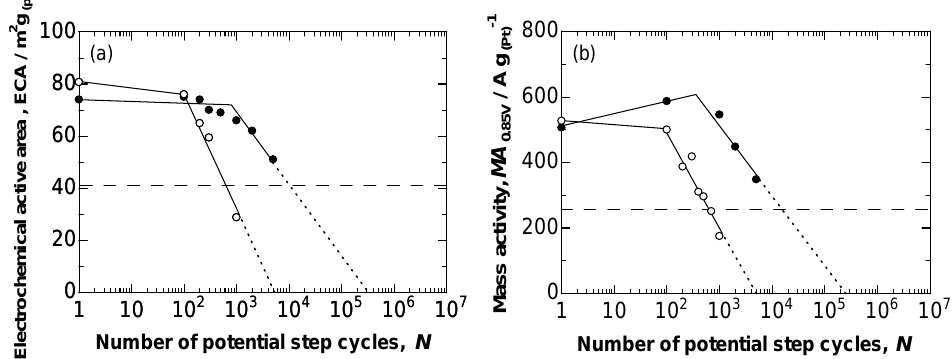
Figure 8. ( a ) Plots of ECA at Nafion-coated ( ● ) Pt/TiC-600 °C and ( ○ ) c-Pt/CB electrodes as a function of log N . ( b ) Plots of MA 0.85V at Nafion-coated ( ● ) Pt/TiC-600 °C and ( ○ ) c-Pt/CB electrodes at 0.85 V as a function of log N . Each dashed line indicates 1/2 of the initial value of ( a ) ECA and ( b ) MA 0.85V for c-Pt/CB.